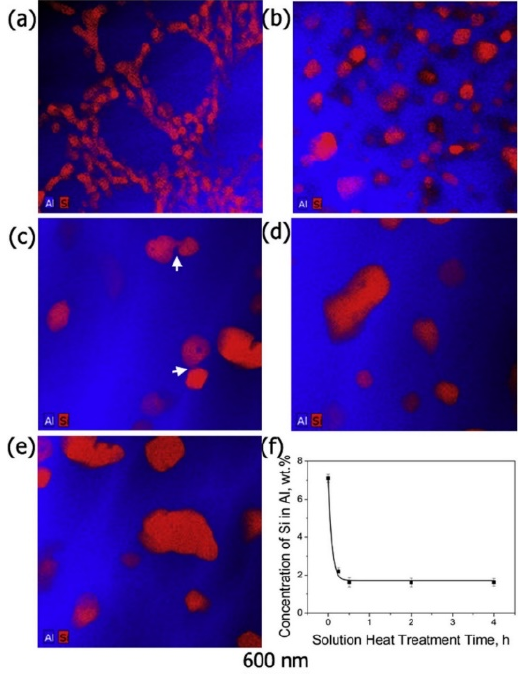
Figure 24. STEM-EDX maps of the Al and Si distribution in the Al-12Si alloy in the ( a ) as-fabricated condition and after solution treatment at 773.15 K for ( b ) 15 min; ( c ) 30 min; ( d ) 2 h; and ( e ) 4 h; ( f ) Concentration of Si in Al for different solution heat treatment durations. The white arrows in ( c ) show the position of the joining neck between adjacent Si particles [130]. Copyright 2015. Adapted with permission from Elsevier Science Ltd. under the license number 4803721064179 (Figure 4 [130]), dated